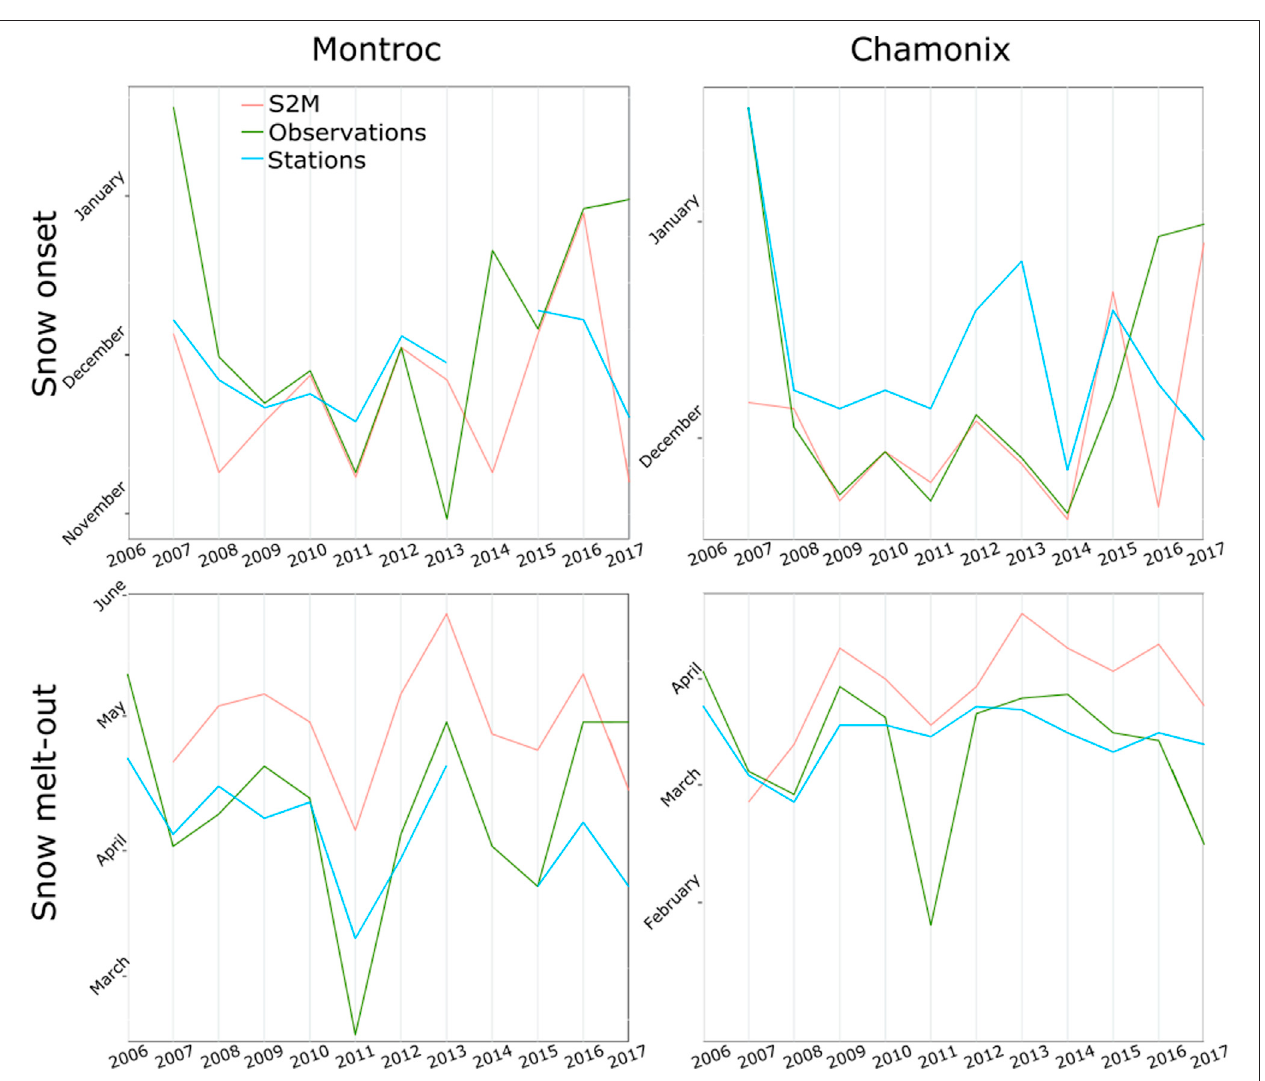
FIGURE 8 | Beginning and ending of the longest period with a snow cover, according to S2M, stations and visual observations at Montroc and Chamonix.